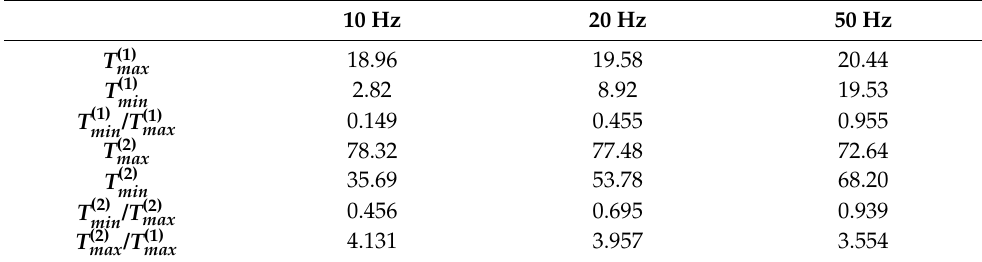
Table 2. The data of the T-t curves of the PDLC film applied with an AC applied square voltage at 10 Hz, 20 Hz, and 50 Hz,